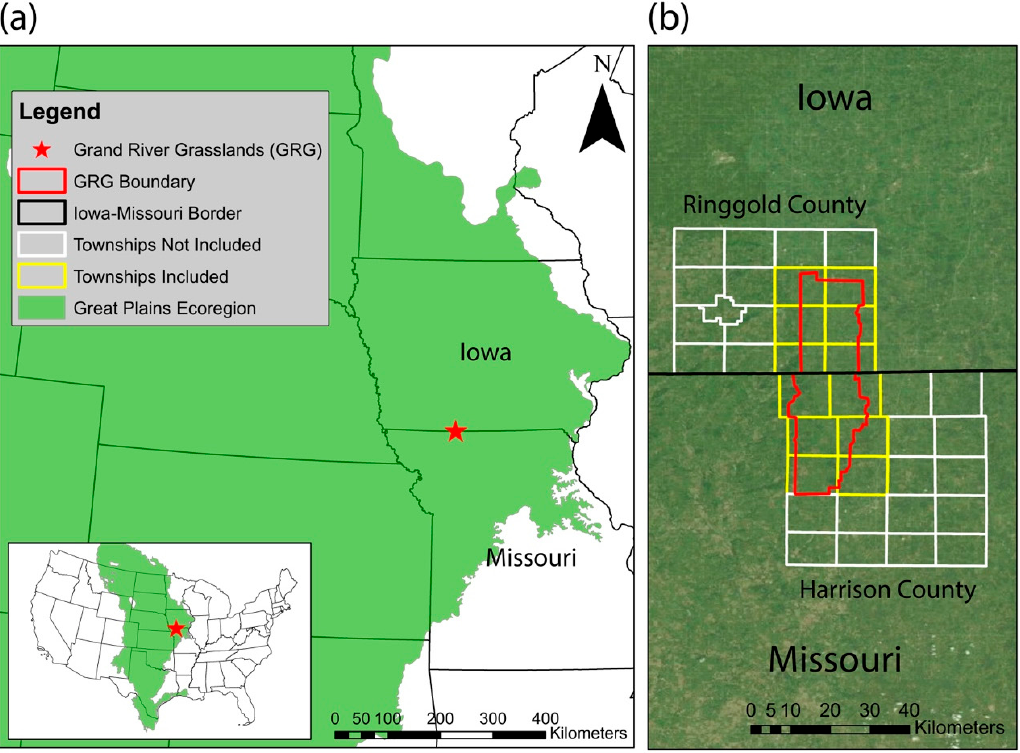
Figure 4. Map depicting ( a ) the location of the Grand River Grasslands (GRG) within the eastern portion of the Great Plains ecoregion as well as ( b ) the boundary of the GRG and the townships included in our study.